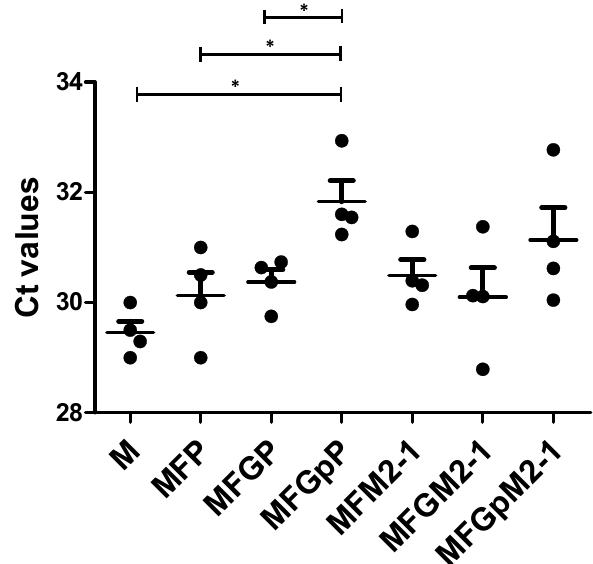
Figure 5. Immunized animals have significantly less lung viral titer. Lungs from immunized animals were homogenized as described in materials and methods. Aliquots stored at − 80 °C were thawed and total RNA was extracted from lung. RNAs were then reverse transcribed into cDNAs. These were used as templates in RT-PCR using CYBR green and a pair of RSV matrix protein M specific primers as described. In parallel, similar reactions were performed using a pair of β -actin specific primers as controls. Results were expressed as relative amount of RSV M compared to β -actin. * p < 0.05. Note the VLPs with Gp appeared most effective at reducing virus replication as indicated by PCR C T values.